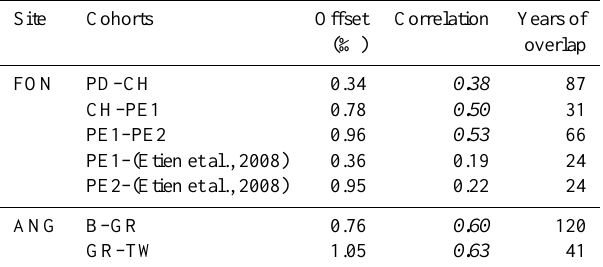
Table 1. Offsets in average δ 18 O c values and correlations between tree cohorts for their periods of overlap. Italics indicate significant correlations ( p < 0 .